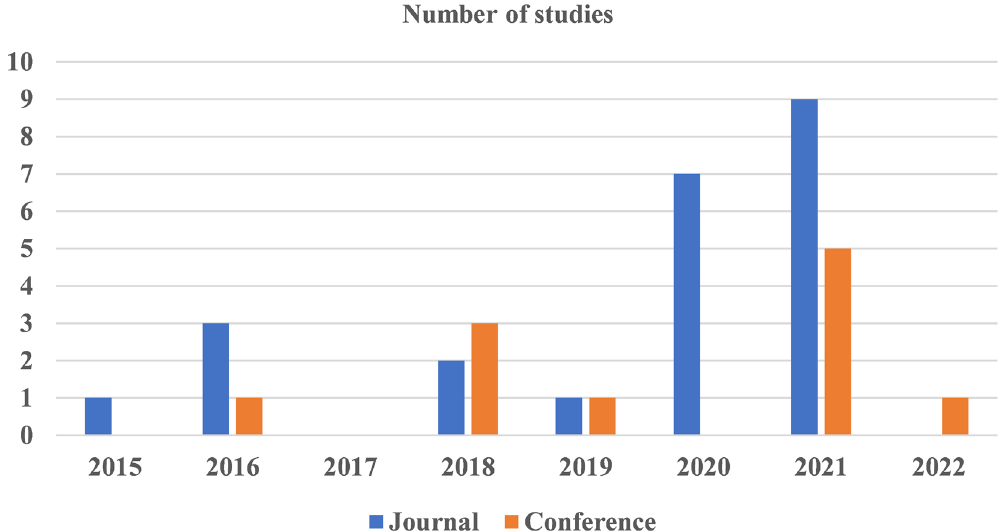
Figure 2. The distribution of studies by the type of publication and the